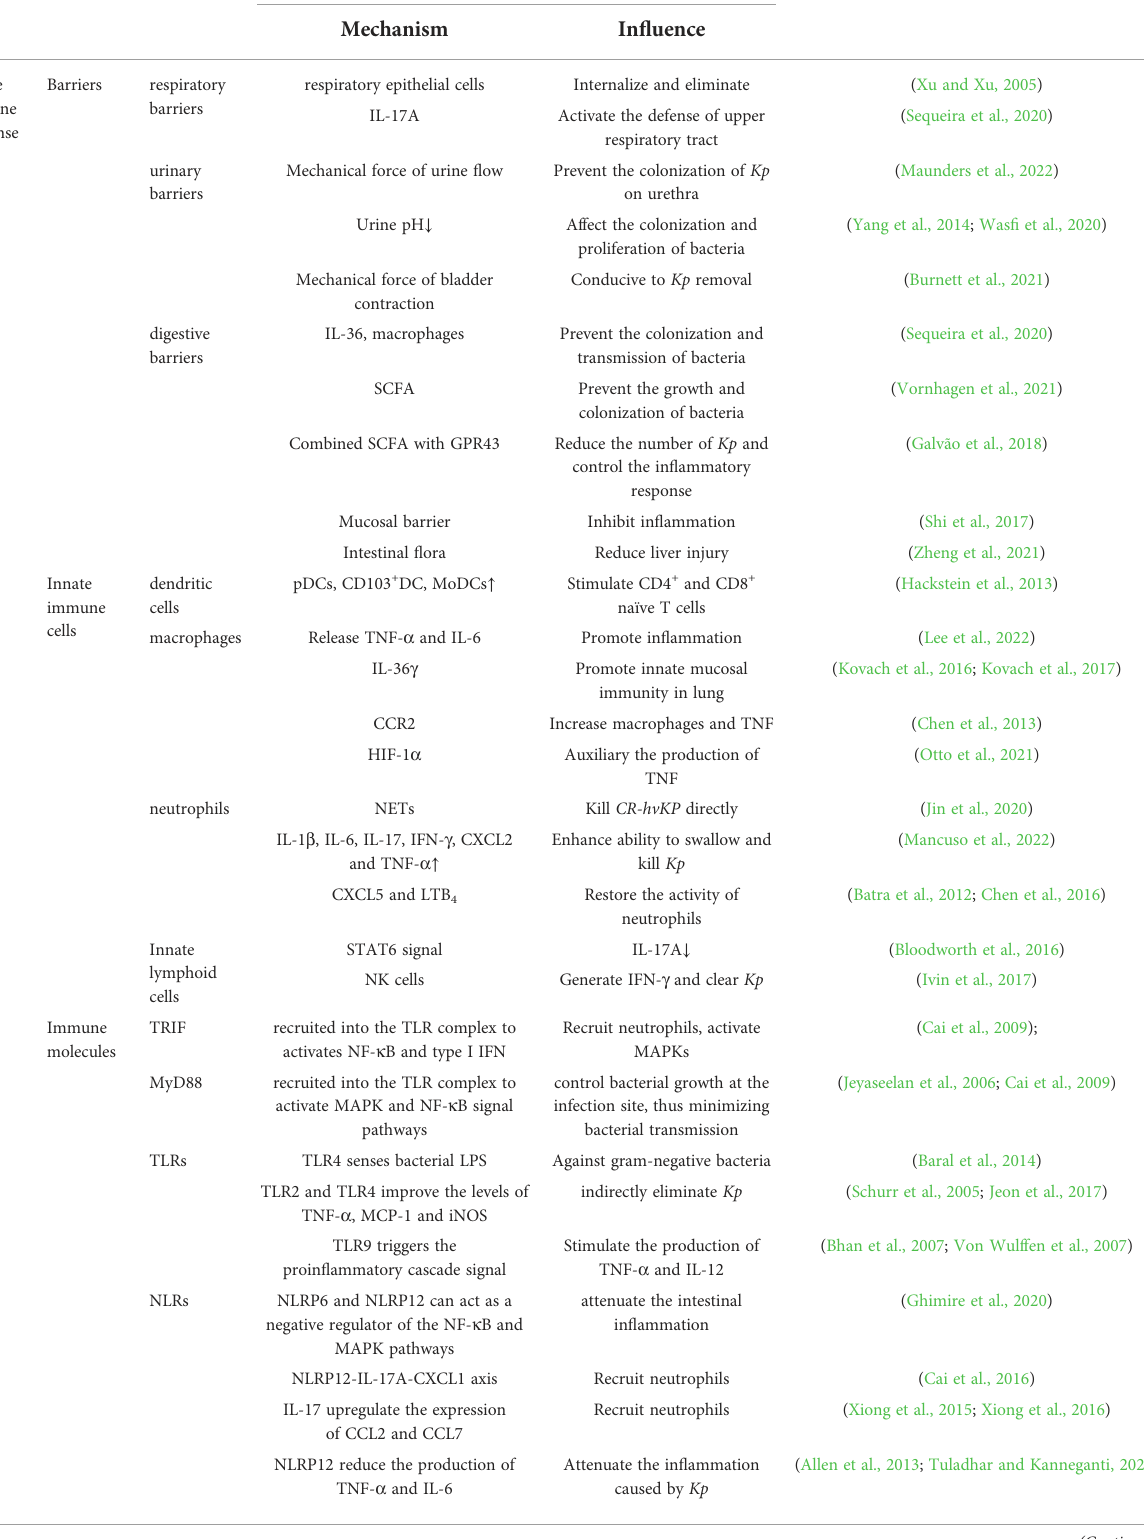
TABLE 1 Studies on the mechanism of host defense against K. pneumoniae (Kp)